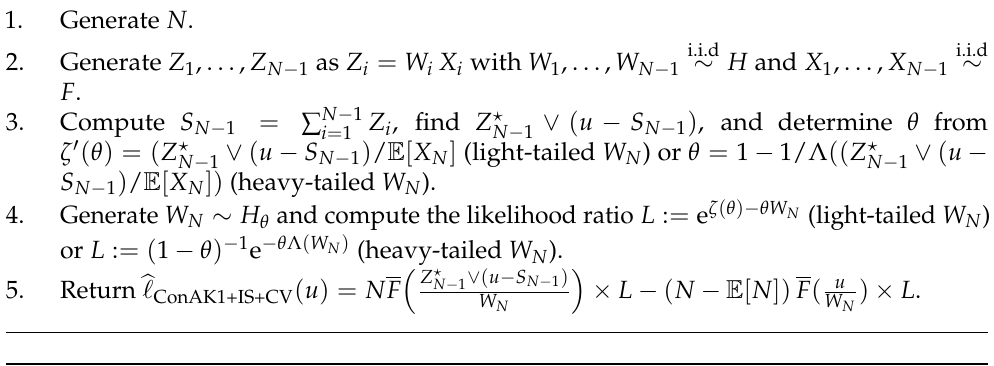
Algorithm 2 Conditional (on X N ) Asmussen–Kroese with importance sampling and control variate